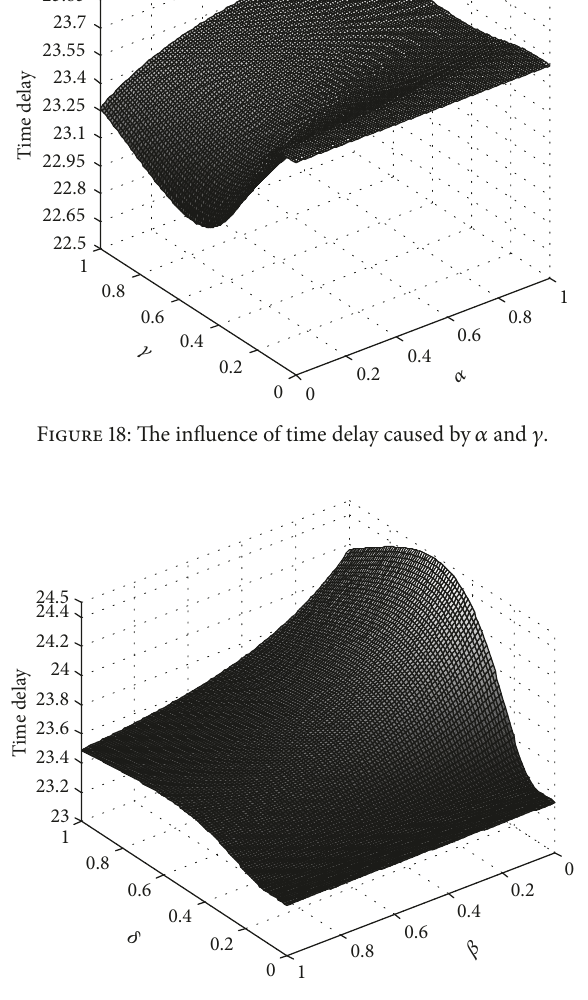
Figure 19: The influence of time delay caused by 𝛽 and 𝛿